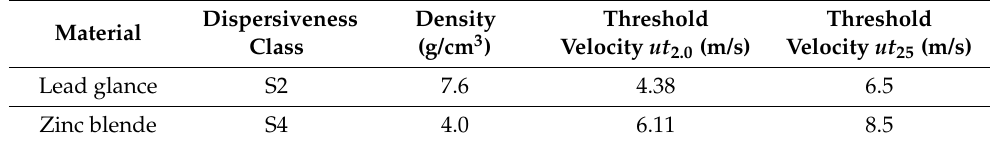
Table 2. Key properties of lead and zinc